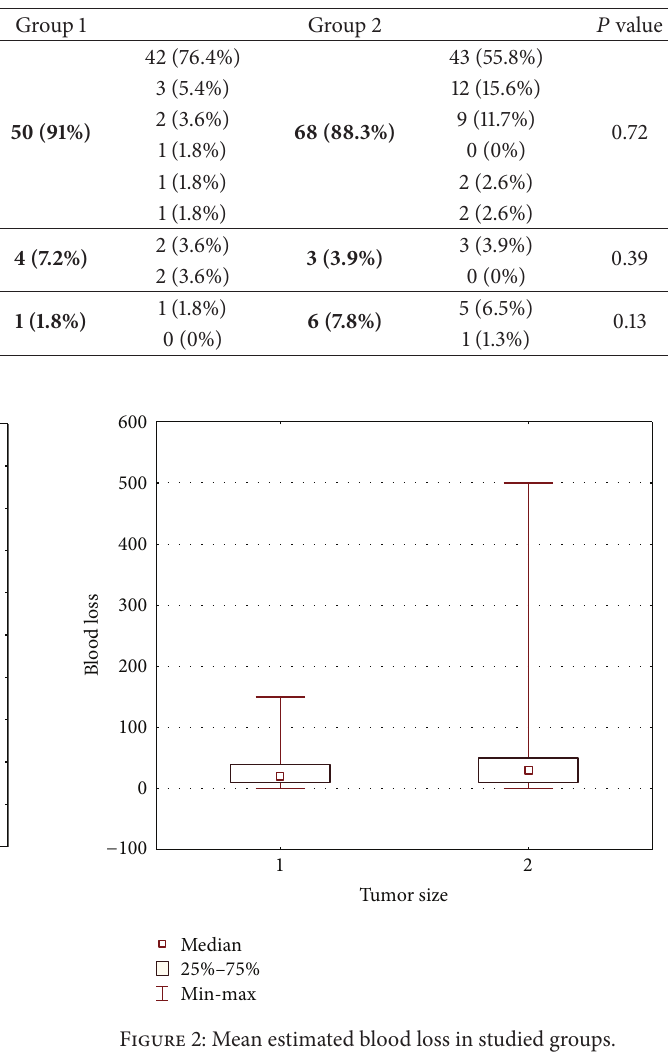
Table 2: Histological types of removed lesions.